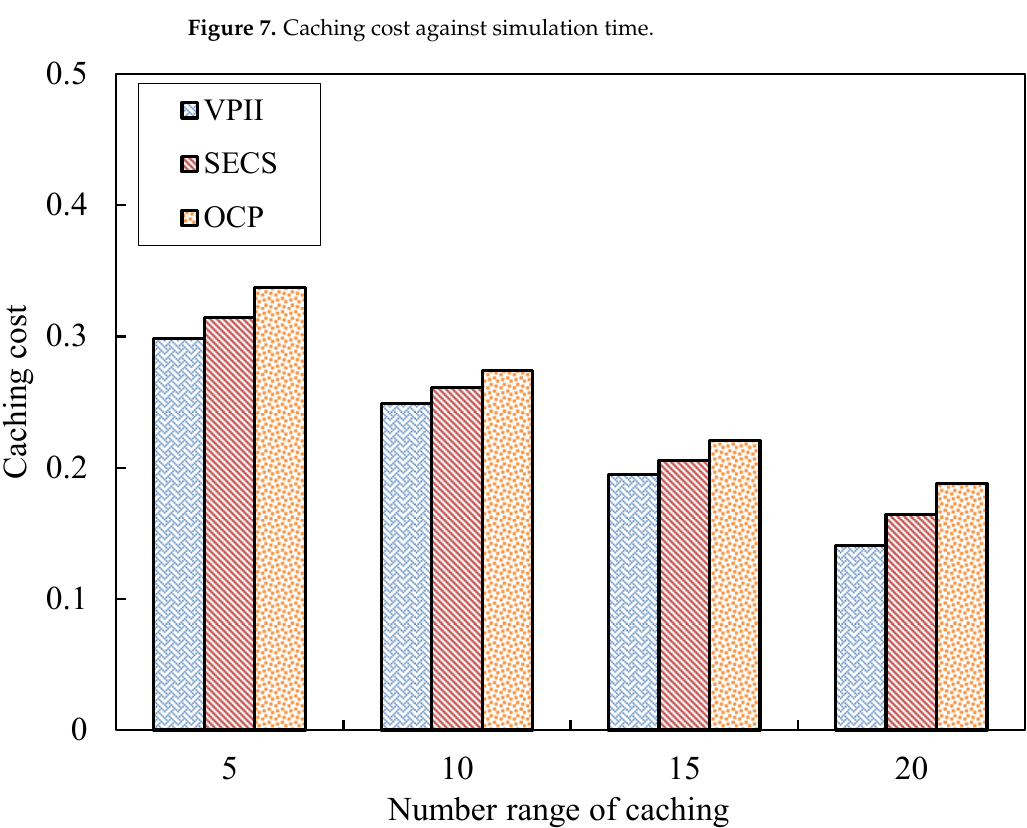
Figure 8. Caching cost against number of cached